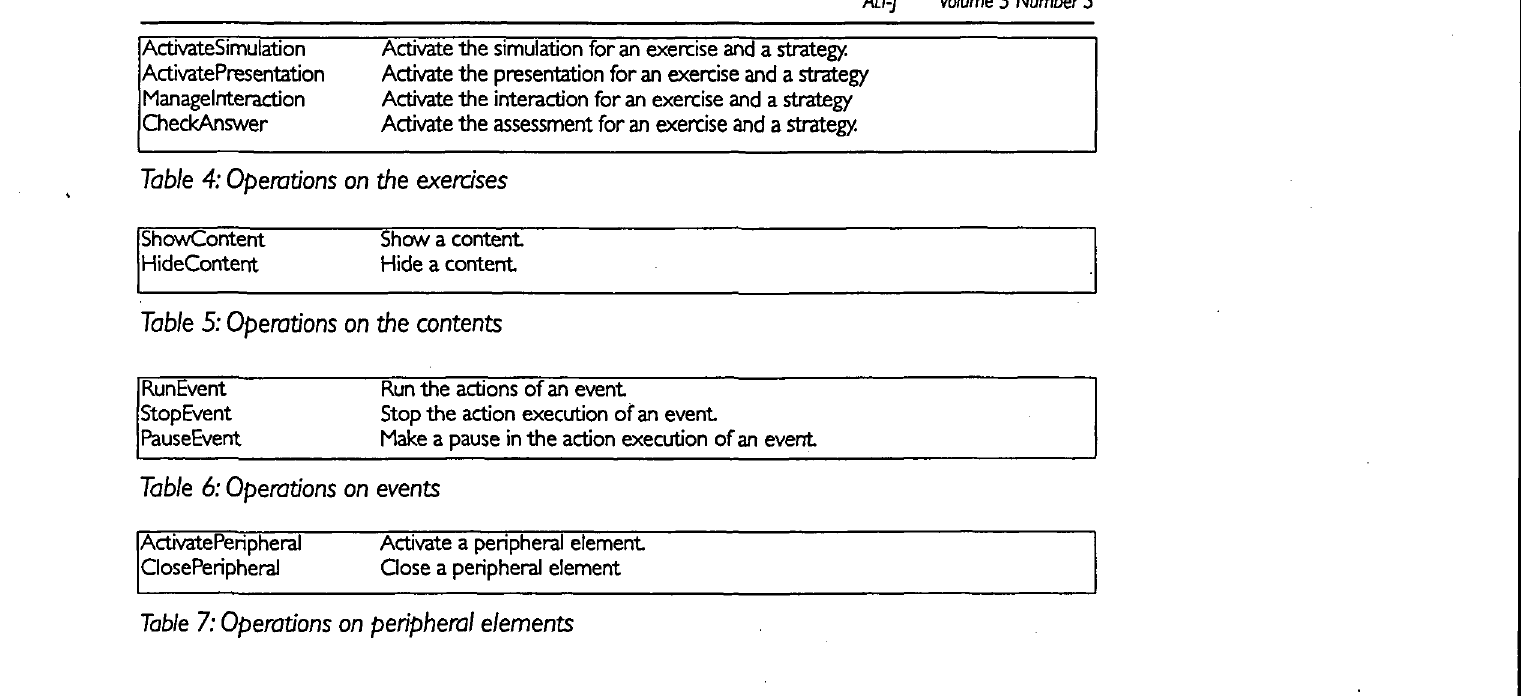
Table 6: Operations on Activate Peripheral ClosePeripheral Table 7: Operations on peripheral